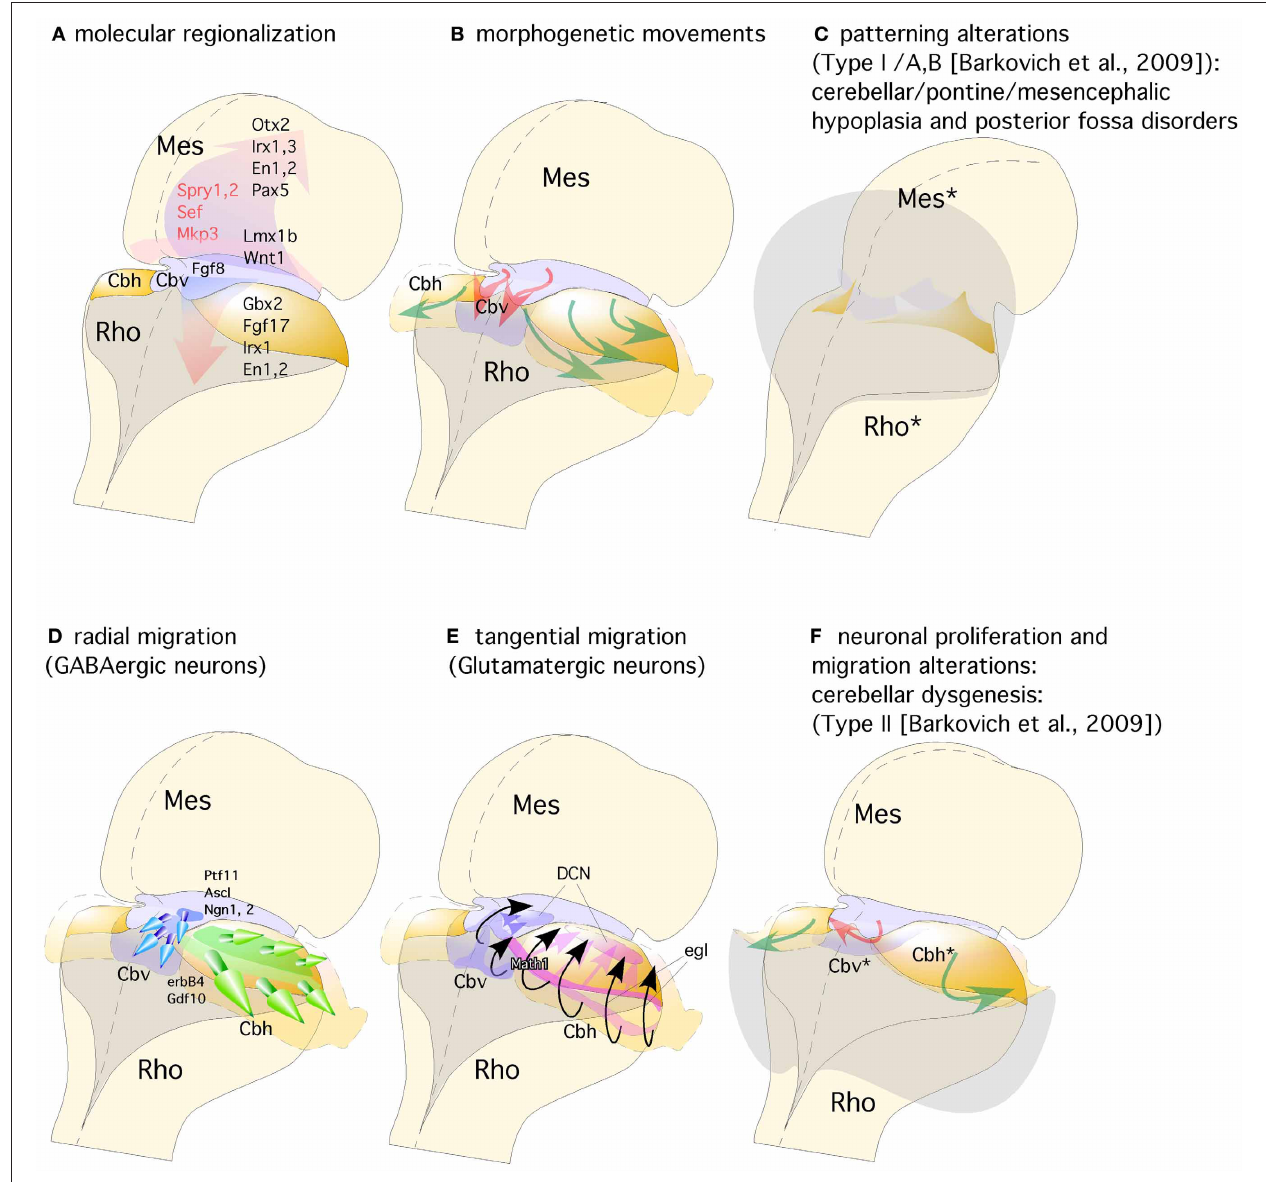
FIGURE 3 | Representation of a dorsal view of mid-hindbrain junction, where the isthmic segment is colored in light purple (which will generate also cerebellar vermis: Cbv) and the cerebellar plates in yellow (which will generate cerebellar hemispheres). (A) The isthmic organizer expressing Fgf 8 (pink arrows) induces the expression of Sprouty , Sef, and Mkp3 in this region; and is also required for other genes differentially expressed in the midbrain (Mes) or rhombencephalic (Rho) neuroepithelium. (B) The spatio-temporal expression of these genes regulates the normal morphogenesisand growth of the cerebellar vermis (Cbv; red arrows) and hemispheres (Cbh; green arrows). (C) Failure in proper isthmic organizer development (due to a lack of morphogenetic signaling or disruption of gene